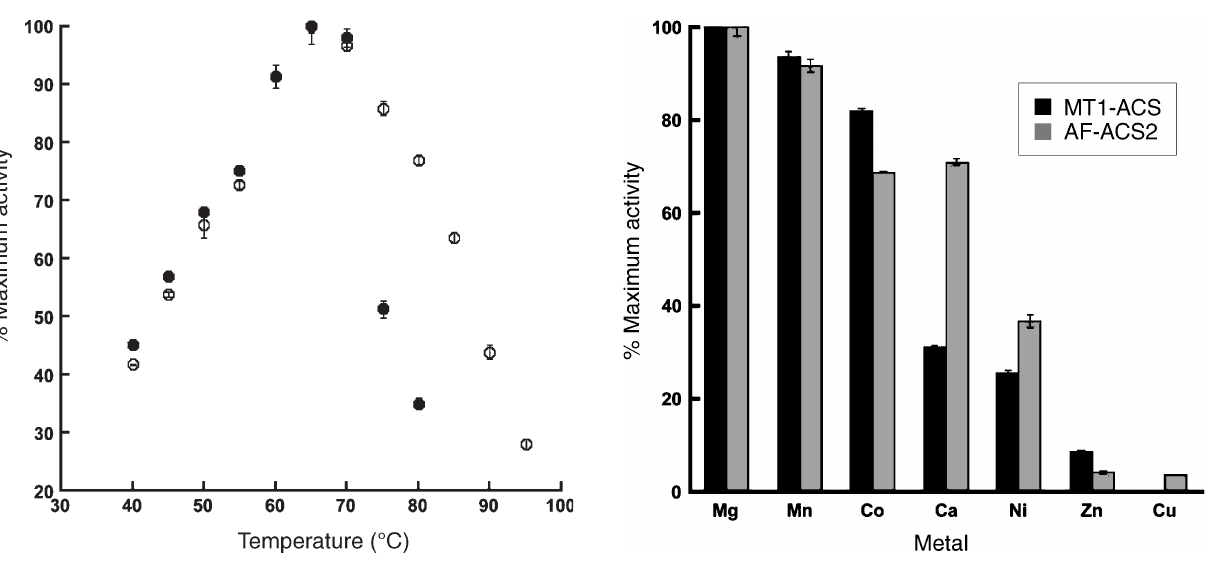
Figure 2. Temperature optima for MT1-ACS and AF-ACS2. Enzyme reactions were performed at the indicated temperatures in triplicate. Activities are reported as a percentage of the maximum activity deter- mined for each enzyme. Symbols: (cid:2) = MT1-ACS; and (cid:3) = AF- ACS2.